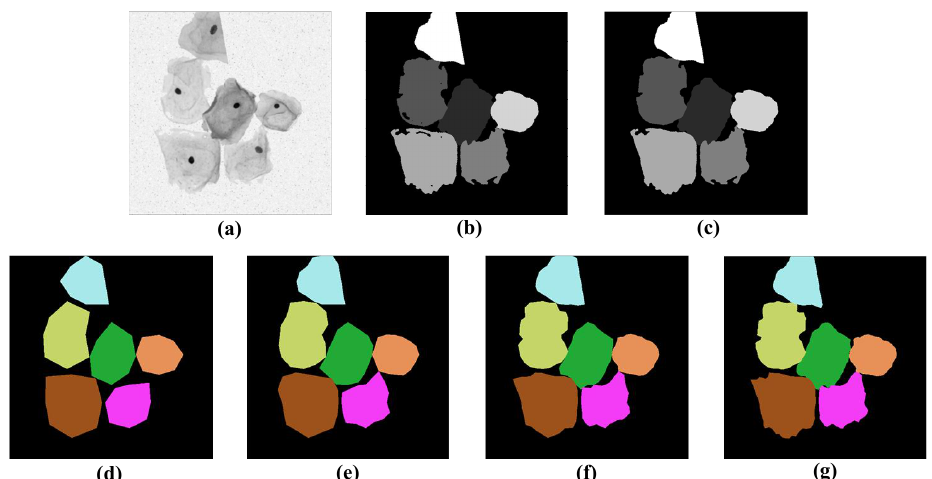
Figure 3. Intermediate results of image pre-processing. ( a ) A sample image, ( b ) the original label with holes, and ( c ) the corresponding filled label. ( d – g ) The label images are based on convex polygons with 8, 16, 32, and 64 vertices,